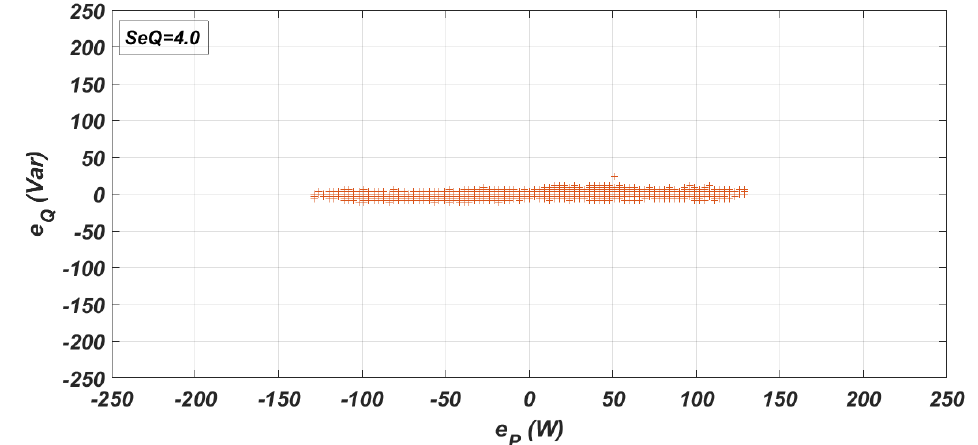
Figure 8. Plot of [ e P ( t ), e Q ( t )] pairs used for the calculation of SeQ for the properly configured PTMVR method.